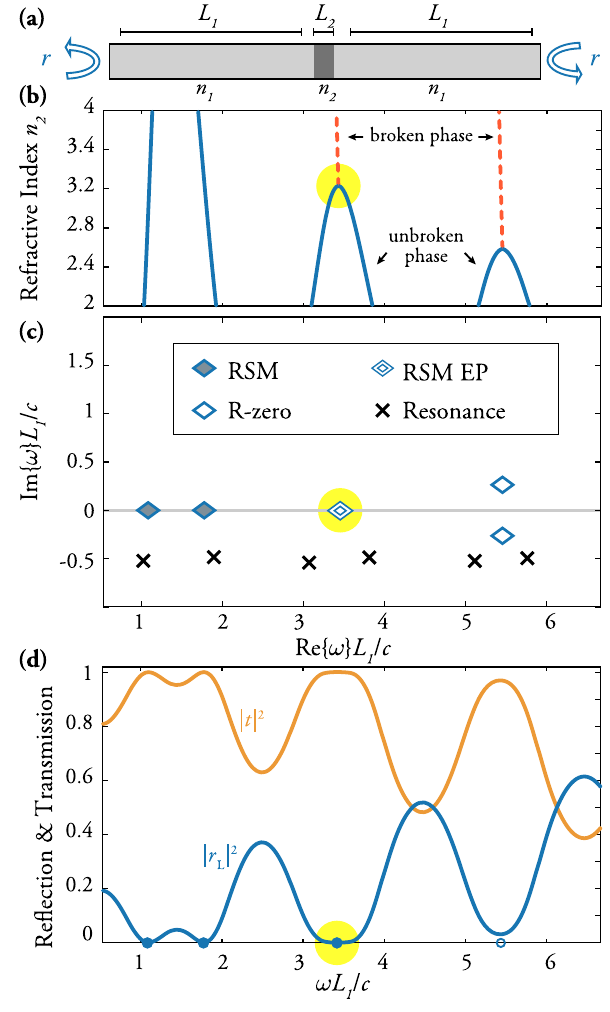
Figure 4: Reflectionless scattering modes (RSMs) in a P + T symmetric